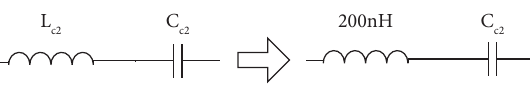
Figure 20: Adjust the second branch of RCN.